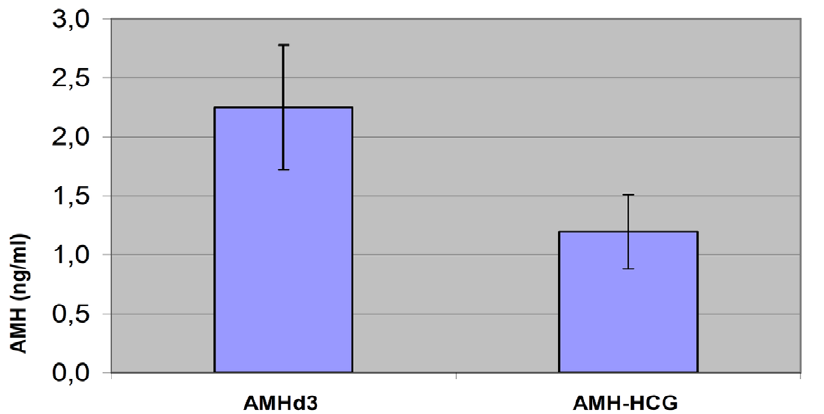
Figure 1. Values of serum AMH: baseline and on day of hCG administration level. Notes: AMHd3=AMH on the 3 th day of the menstrual cycle (baseline). AMH-HCG=AMH on the day of hCG administration. T test for paired data. AMHd3 vs AMH-HCG: t=5,484; p , 0,001.